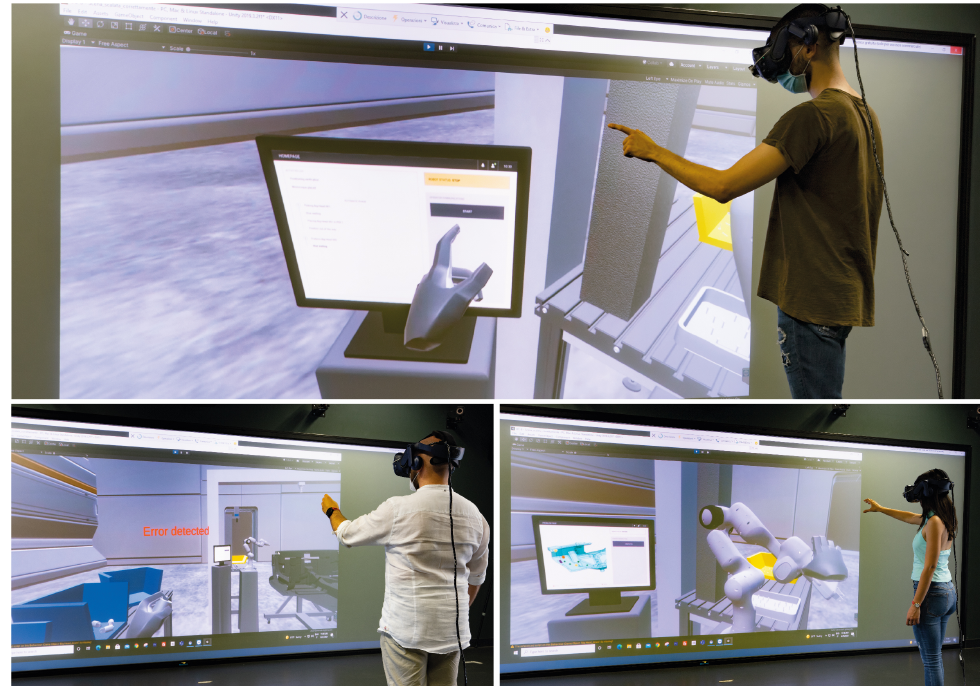
Figure 16. Pictures of three testing sessions for case